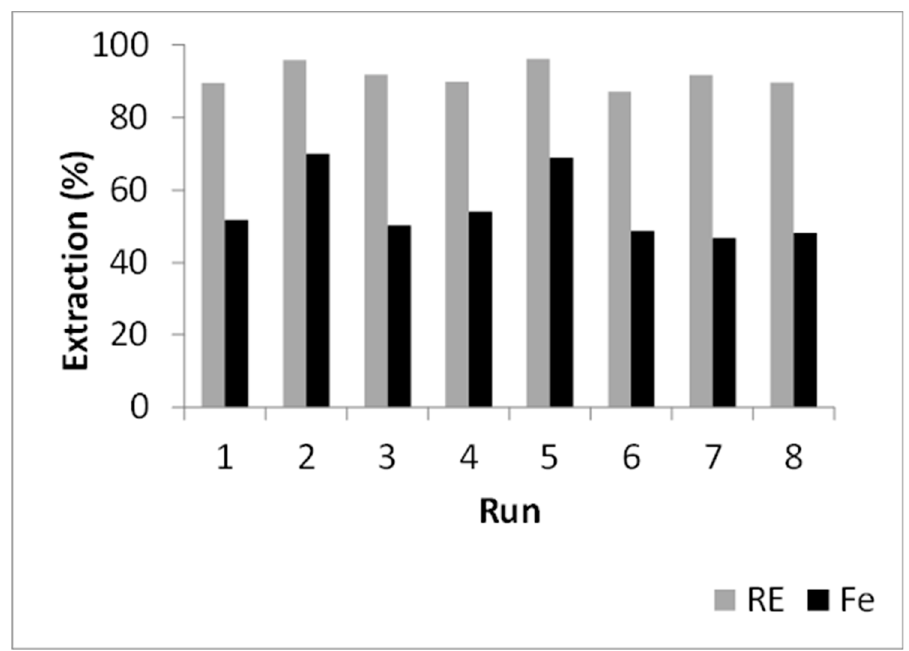
Figure 5. Extraction of rare earth element (REE) (%RE) and Fe (%Fe)—screening experiments. Minerals 2019 , 9 , x FOR PEER REVIEW